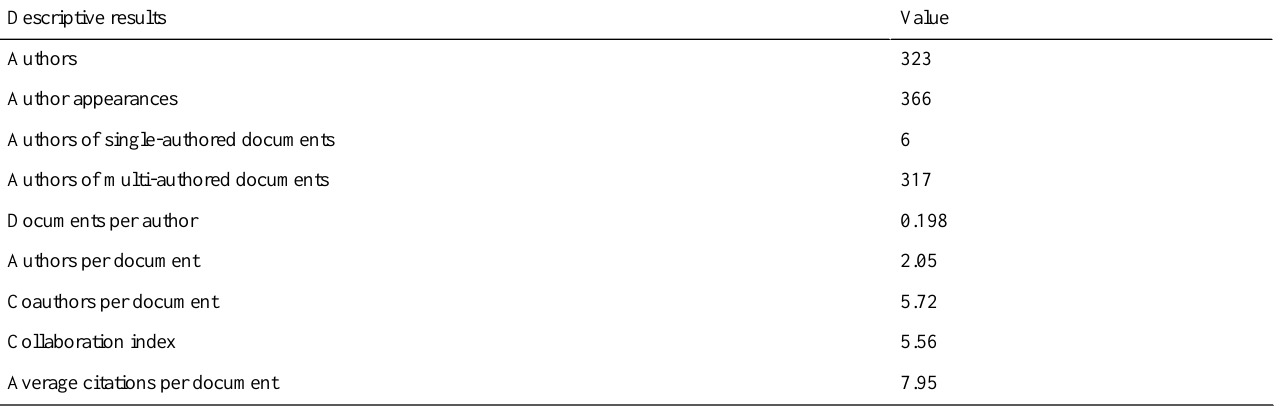
Table 2. Author and coauthor descriptive results for all documents published between 2010 and 2019.